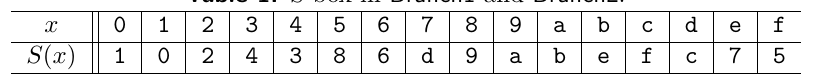
Table 1: S-box in Branch1 and Branch2